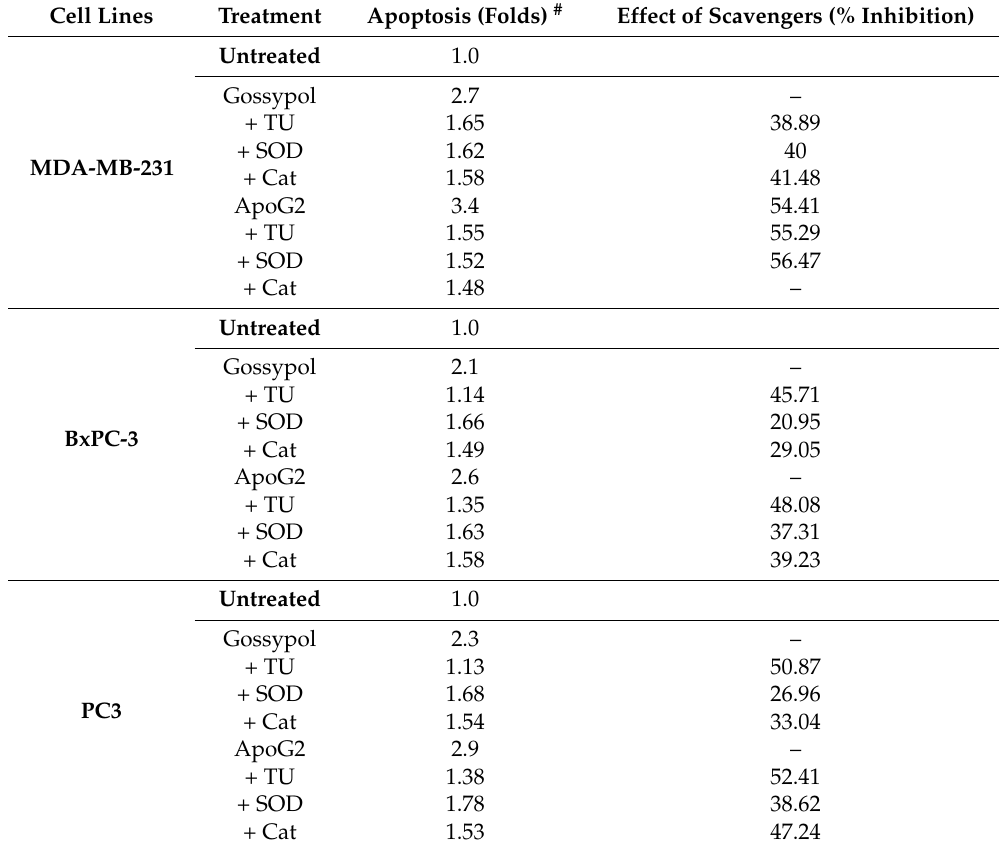
Table 1. Effect of reactive oxygen species (ROS) scavengers on gossypol and ApoG2-induced apoptosis in cancer cell lines. Cancer cell lines were incubated with different ROS scavengers, and treated with gossypol/ApoG2, as described in the Methods. Cell Death Detection ELISA Kit was used to assess the induction of apoptosis, as described above. Gossypol/ApoG2, 5 μ M; TU, 700 μ M thiourea; SOD, 100 μ g/mL superoxide dismutase; Cat, 100 μ g/mL catalase. p < 0.05 compared to treated control.